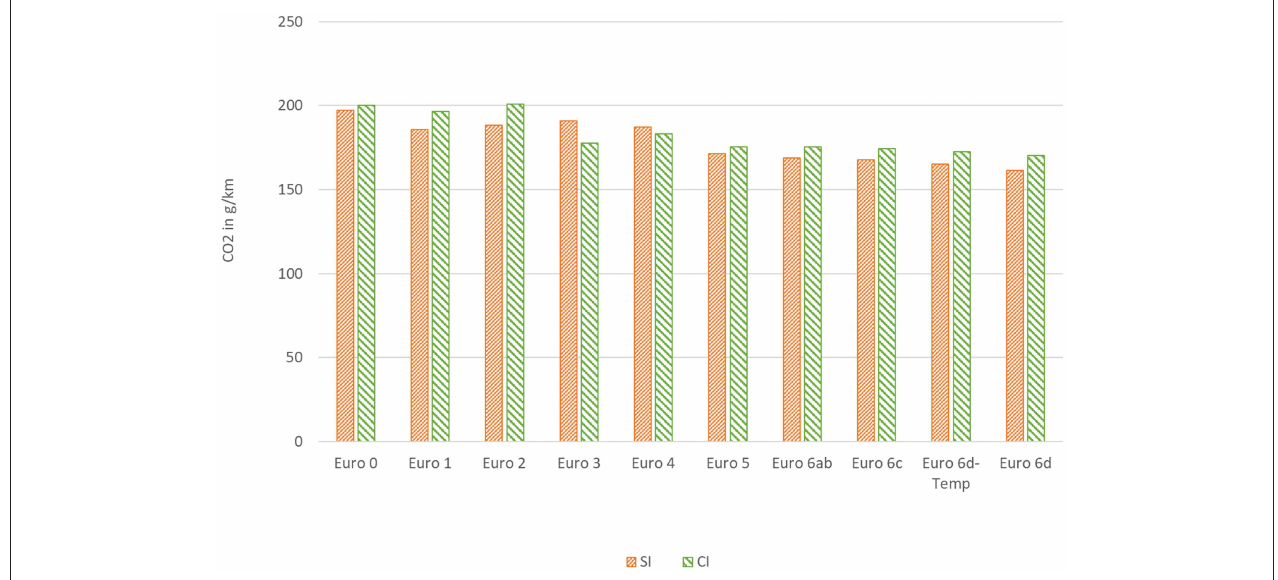
FIGURE 7 | Average hot CO 2 emission factors of the passenger car segments for HBEFA (calibrated to German driving and vehicle conditions) adapted from Matzer et al. (2019) with permission of TU Graz. artifact from different measurement systems for PN. For